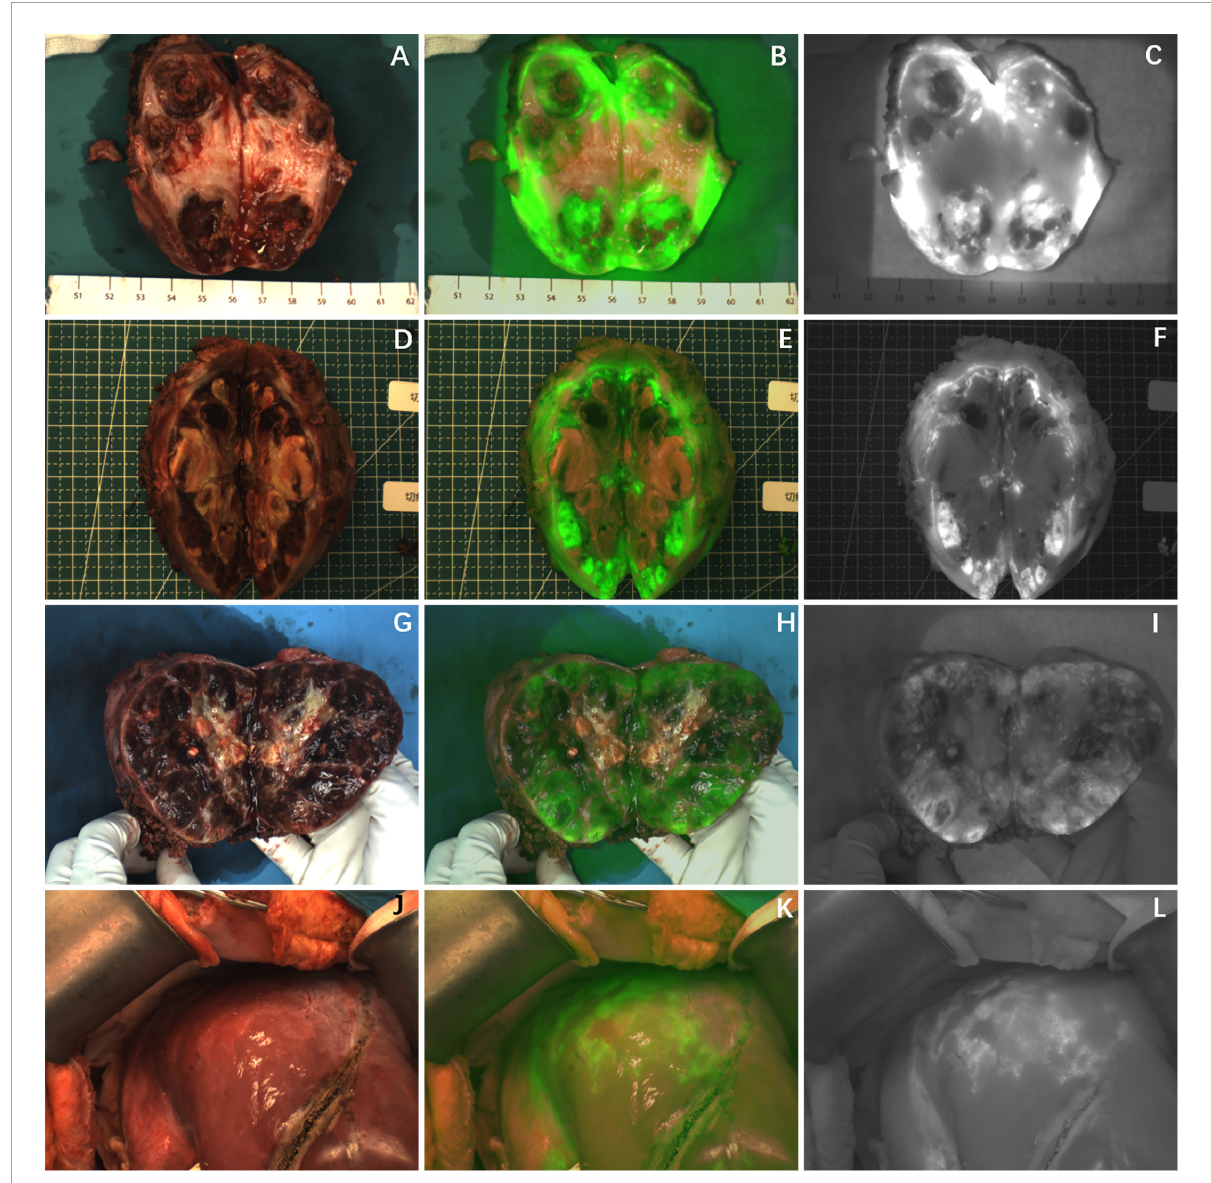
FIGURE3 The tumor after chemotherapy showed partial fluorescence imaging, and there was no fluorescence in the area of necrosis or fibrosis. (A–I) Fluorescence imaging of 3 cases of HB tumors in vitro ; (J–L) fluorescence imaging of UESL tumor in vivo . The white-light image, fusion image and fluorescence image are shown in turn from left to